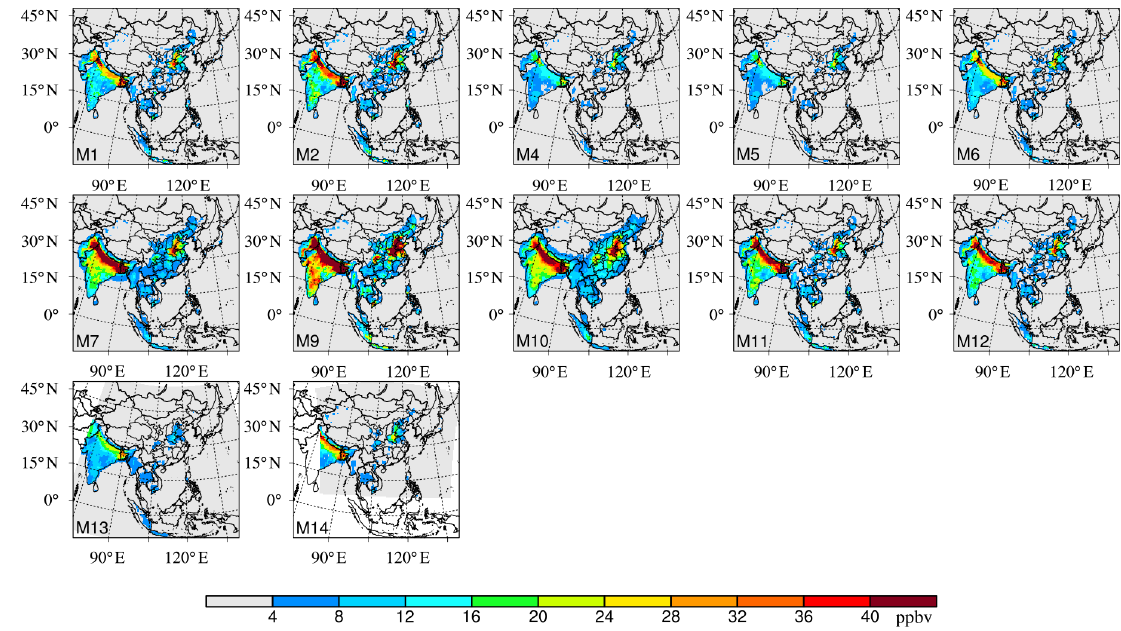
Figure 8. Spatial distribution of the annual mean NH 3 concentrations from each modeling results of MICS-Asia